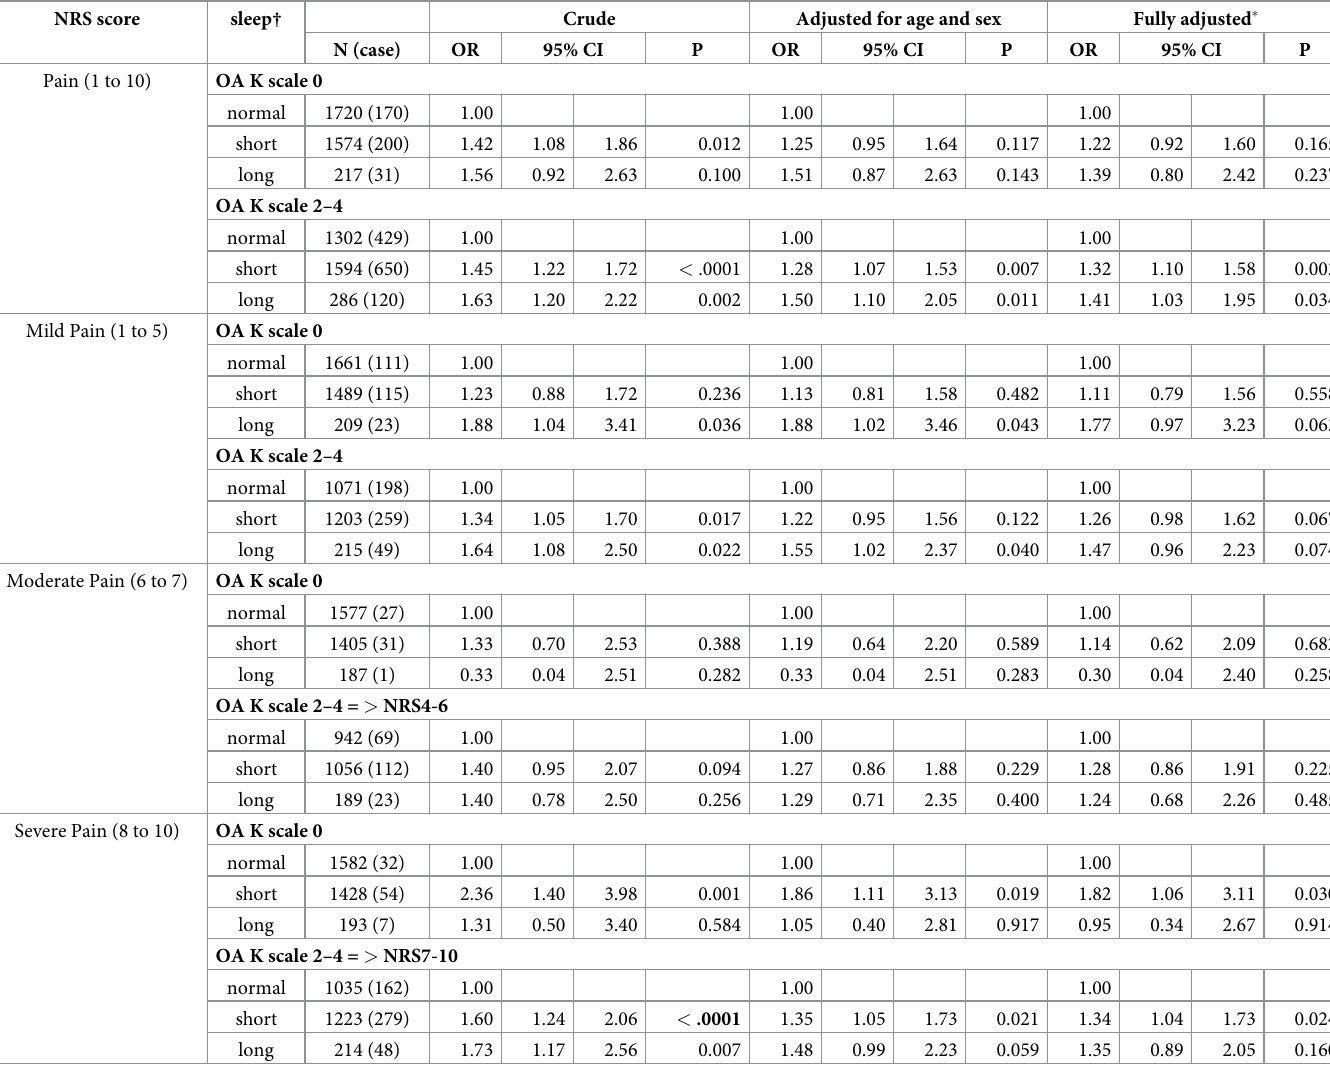
Table 5. Relationship between sleep time duration and joint pain in adults aged � 50 years, according to different pain score levels. NRS score